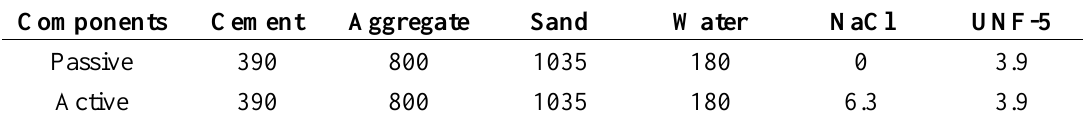
Table 1. C30 concrete mixture proportions (units: kg/m 3 ).